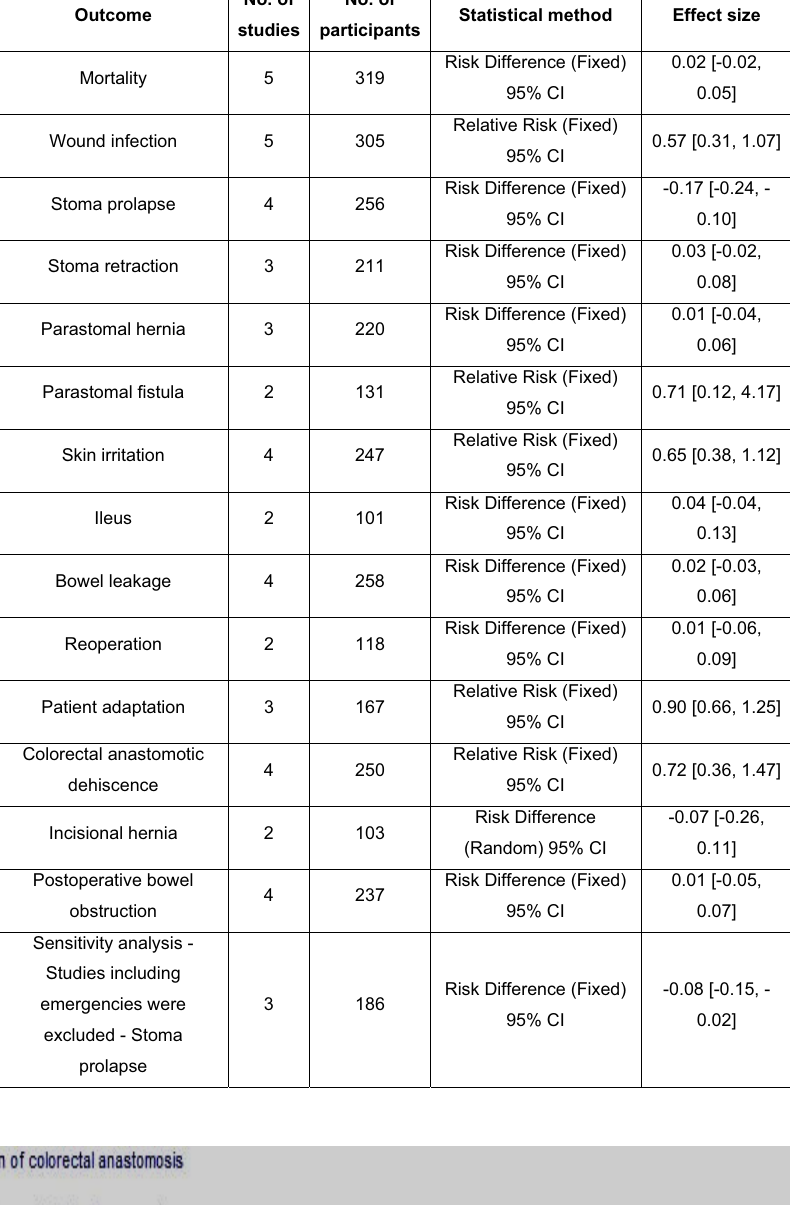
TABLE 5 - ILEOSTOMY VS. COLOSTOMY